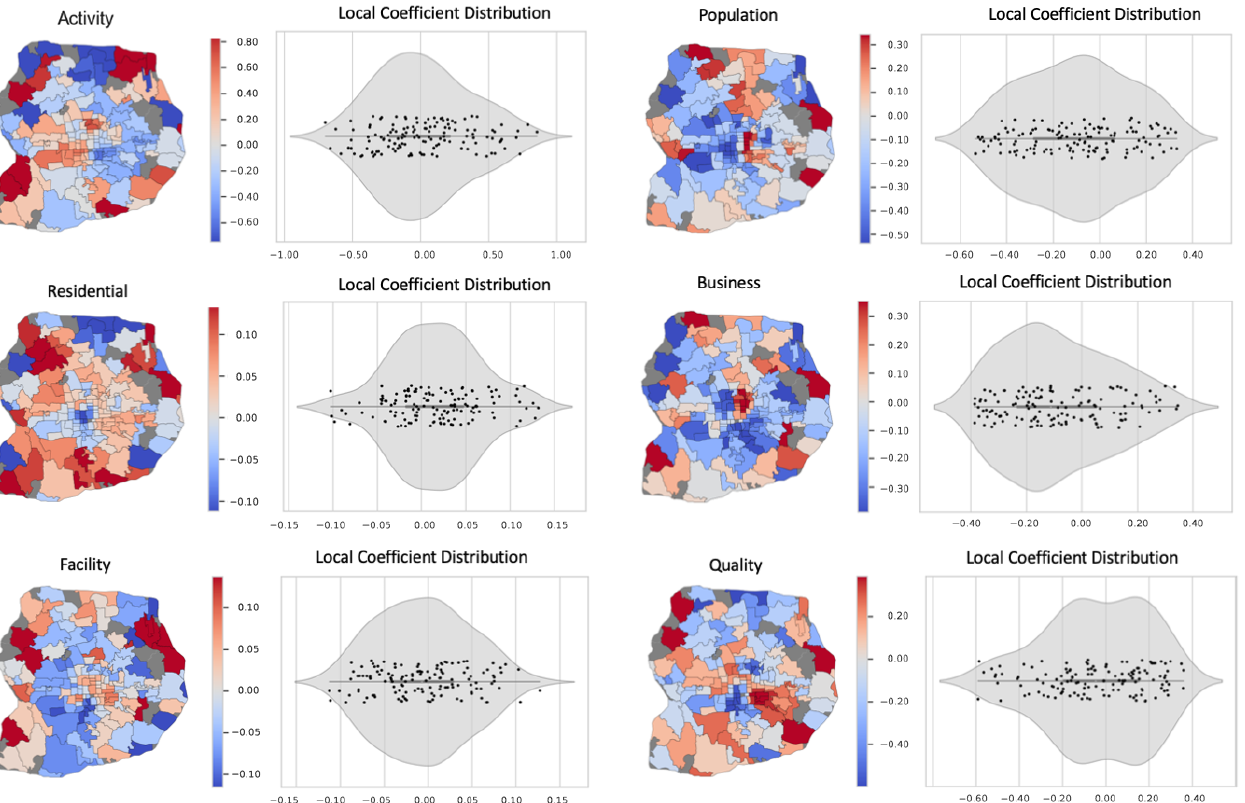
Figure 7. Local coefficient distribution and spatial patterns for vibrancy indicators and physical activity at neighborhood scale.